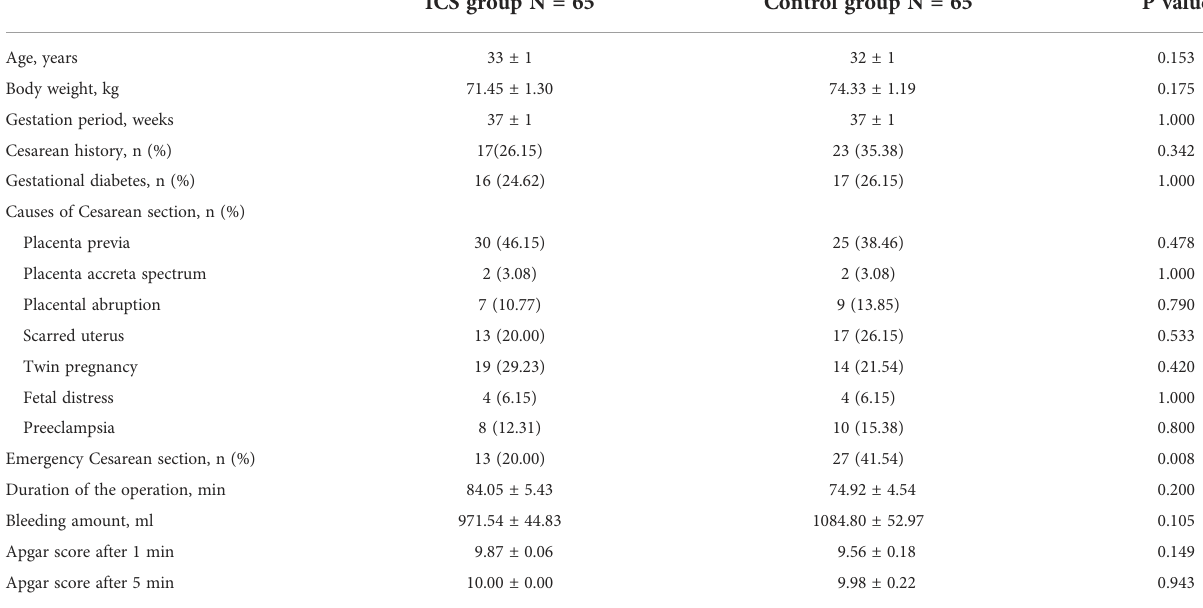
TABLE 1 Clinical characteristics of